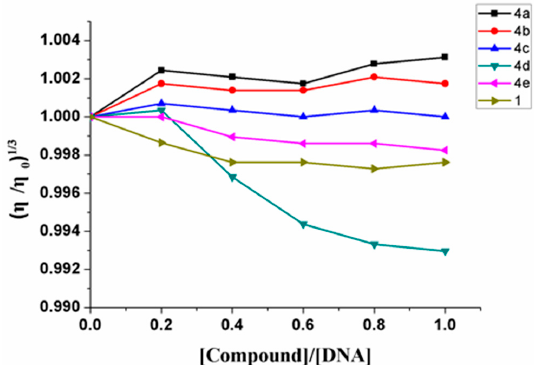
Figure 3. DNA viscosity titration of different bis-naphthalimide compounds 4a – e at 35 °C in 25 mL phosphate buffer (50.0 mM, pH = 7.4). The concentration of DNA was 0.56 mM and the ratios between bis-naphthalimide compounds and DNA were 0.2, 0.4, 0.6, 0.8, and 1.0, respectively.